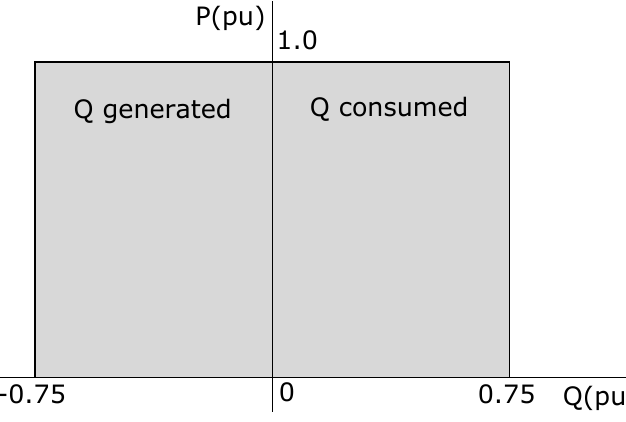
Figure 5. P ‐ Q characteristic of the full converter wind turbine.